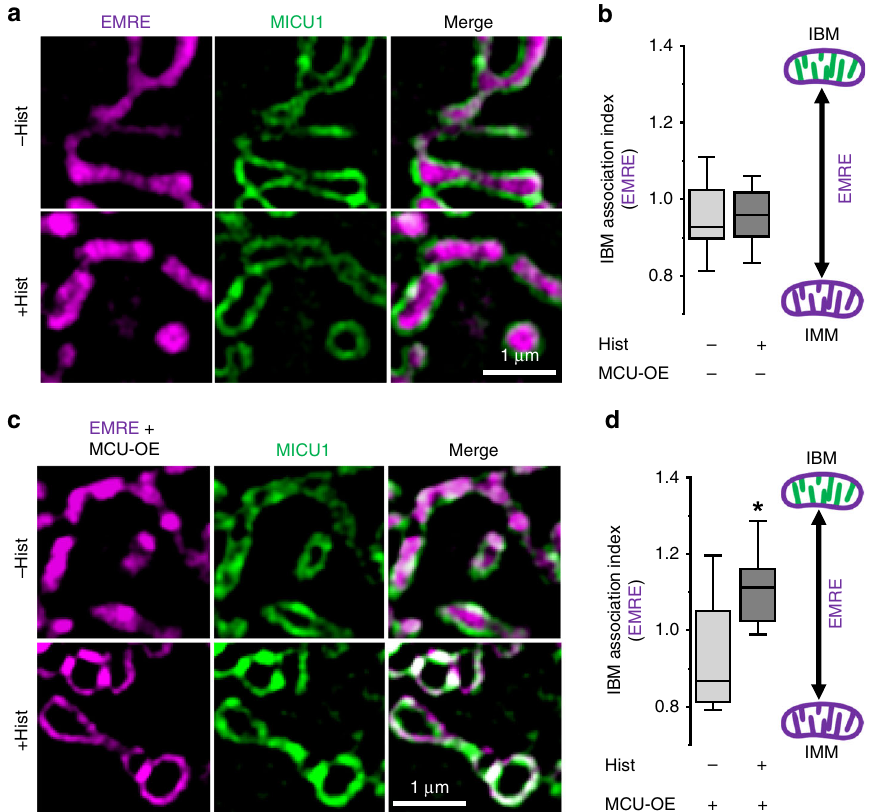
Fig. 7 EMRE redistributes in a MCU-dependent manner to the IBM under ER Ca 2 + release. a Representative SIM images of HeLa cells that were transiently transfected with EMRE-mCherry (magenta) and MICU1-YFP (green) under resting conditions and 90 s after stimulation with 100 µ M histamine. b The sub- mitochondrial localization of EMRE-mCherry under resting conditions ( − Hist) and 90 s after treatment with histamine (100 µ M) ( + Hist) was determined by the IBM association index ( n = 8). c Identical experiments as those in a but using cells that overexpressed wild-type MCU. d Identical experiments as those in b but using cells that overexpressed wild-type MCU ( n = 8). Horizontal lines represent the median, the lower and upper hinge show respectively fi rst quartile and third quartile, and lower and upper whisker encompass minimal and maximal values. Images and analyses were obtained from at least 10 cells in each of 8 experiments. * P < 0.05 vs. respective control conditions carried out with unpaired double-sided T -test. Source data are provided as